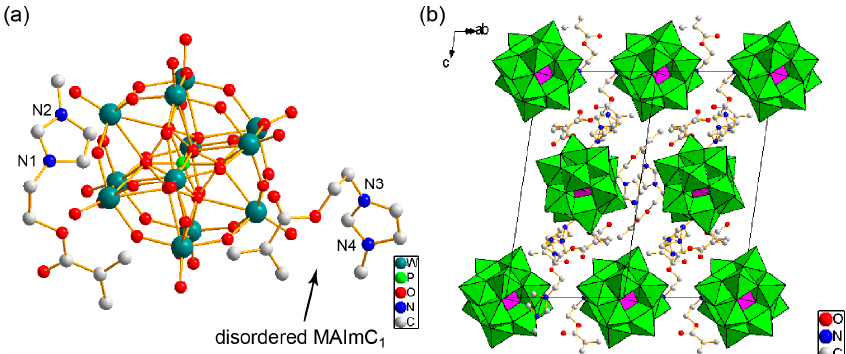
Figure 3. Crystal structure of MAImC 1 -PW 12 hybrid monomer. H atoms are omitted for clarity: ( a ) asymmetric unit together with PW 12 anion completed by symmetry operation (0.5 − x , 0.5 − y , 1 − z ); and ( b ) packing diagram along the [ − 1, 1, 0] direction.